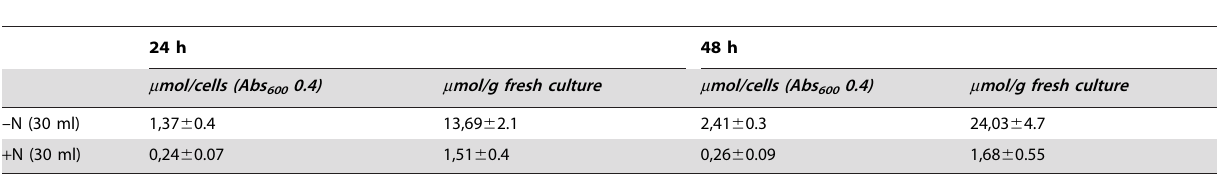
Table 1. Determination of Azoarcus sp. CIB nitrogenase activity.